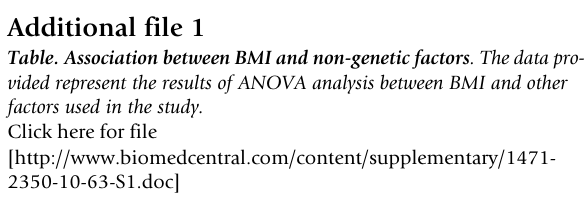
Table. Association between BMI and non-genetic factors . The data pro- vided represent the results of ANOVA analysis between BMI and other factors used in the study. Click here for